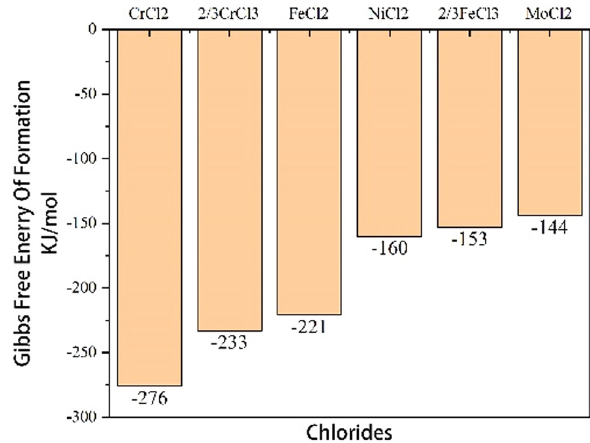
Figure 11: Gibbs free energy of formation per molecule Cl 2 for various chlorides at